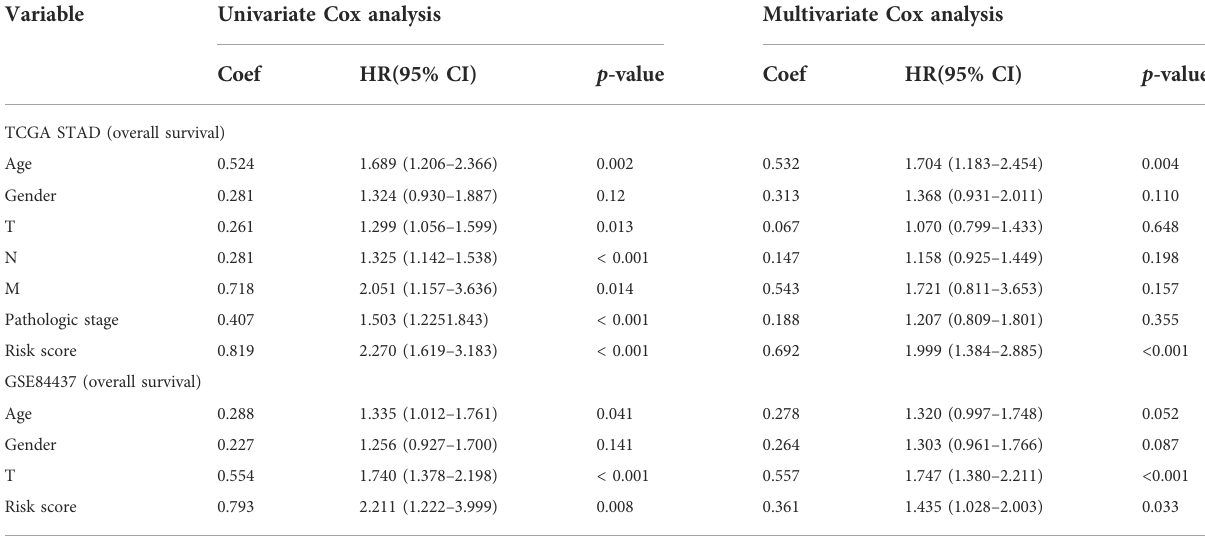
TABLE 3 Univariate analysis and multivariate analysis of the correlation of risk score with the outcomes among stomach adenocarcinoma patients in two cohorts.